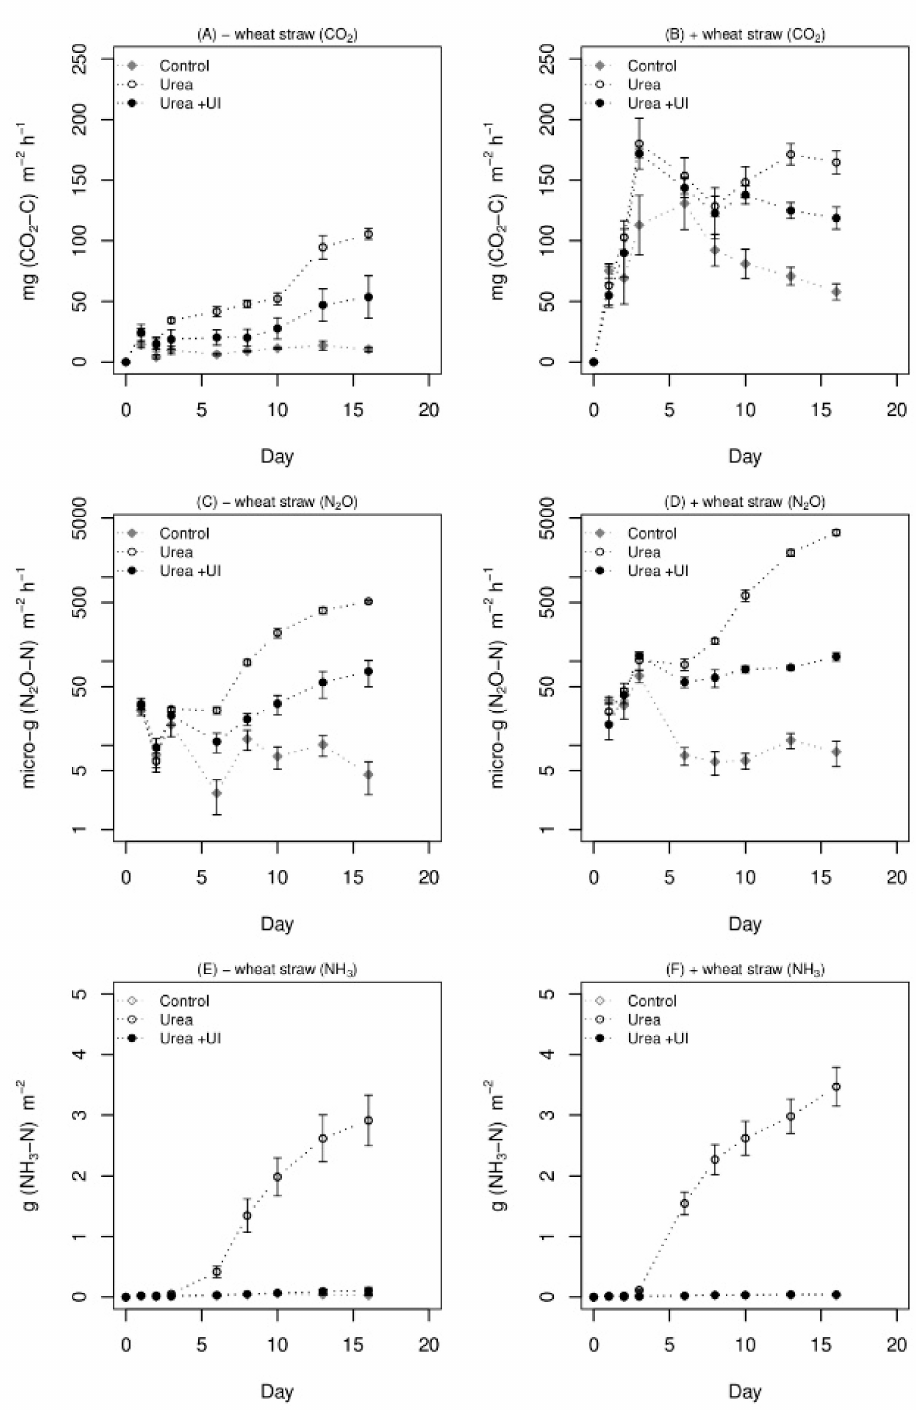
Figure 2. Flux rates of CO 2 -C ( A , B ) and N 2 O-N ( C , D , logarithmic scale) and total loss of NH 3 -N ( E , F ) from alkaline soil of the NCP after application of urea and urea + UI (NBPT) without (left) and with (right) incorporated wheat